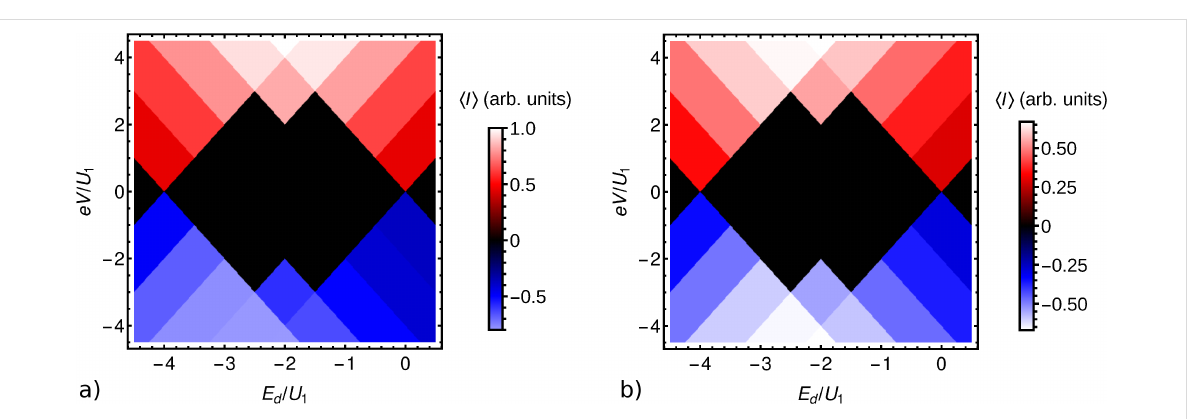
Figure 7: Average current per site for a) asymmetric tunneling, Γ top / Γ bottom = 0.5, and b) symmetric tunneling, Γ top / Γ bottom = 1 [15], both for a degeneracy of 2 of occupied single-site states.